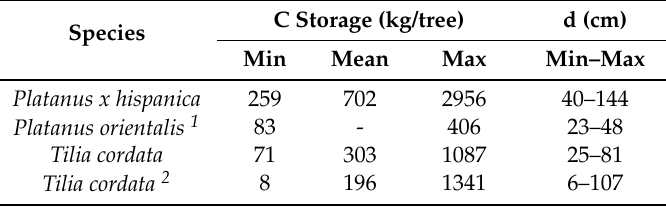
Table 7. Comparison of carbon storage capacity based on the estimation of above ground woody biomass for trees in the present study with other studies in urban areas and the related diameter range. C Storage (kg/tree) d (cm) Species Min Mean Max